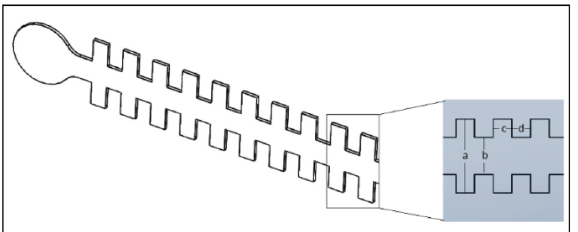
Figure 1. The 3D design of microchannels with cavities. Aspect ratio (a/b) was defined as three (3) for all configurations with various dimensions. The values of the parameters c and d are equal.